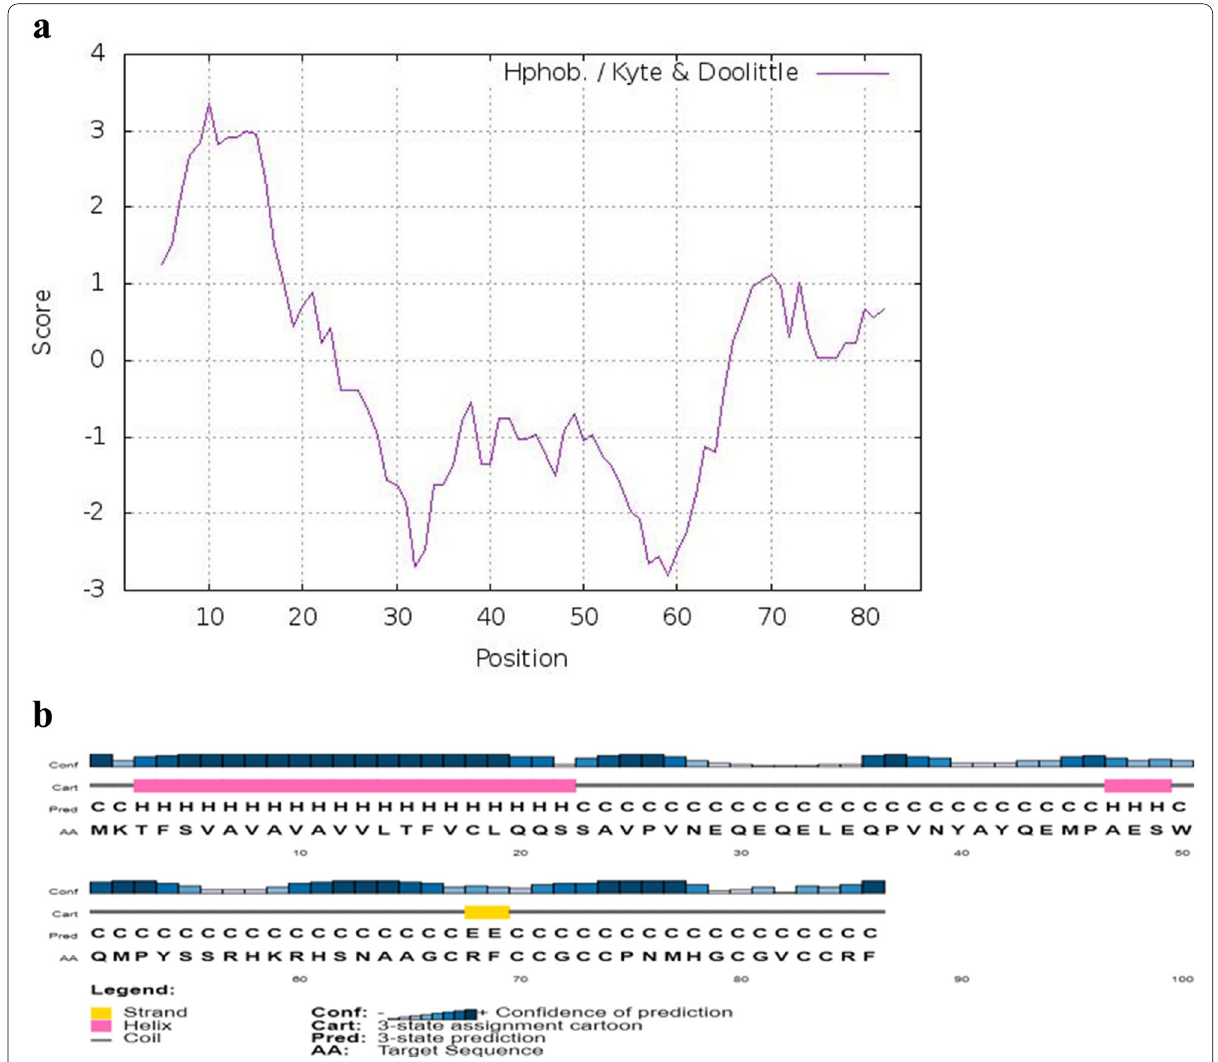
Fig. 2 a Kyte-Doolittle plot showing hydrophobicity of Cc -Hep. The peaks above the score (0.0) indicate the hydrophobicity. The X axis is represented by amino acid sequence positions and Y axis by hydrophobicity score. b Secondary structure of Cc -Hep peptide predicted using PSIPRED server. Alpha helical structure represented by pink color, beta strand by yellow color and coils by grey color